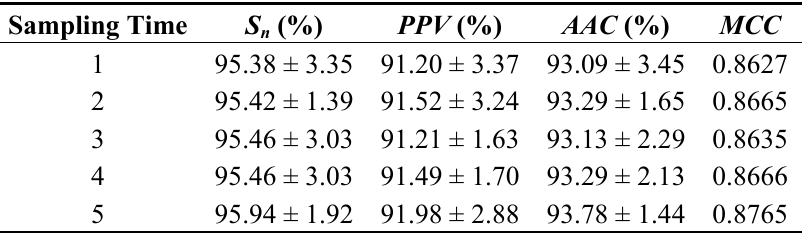
Table 4. Effect of random sampling of the noninteracting protein subchain pairs on the performance of PPI-PKSVM with DFPCA and PRBF SVM in the 10CV